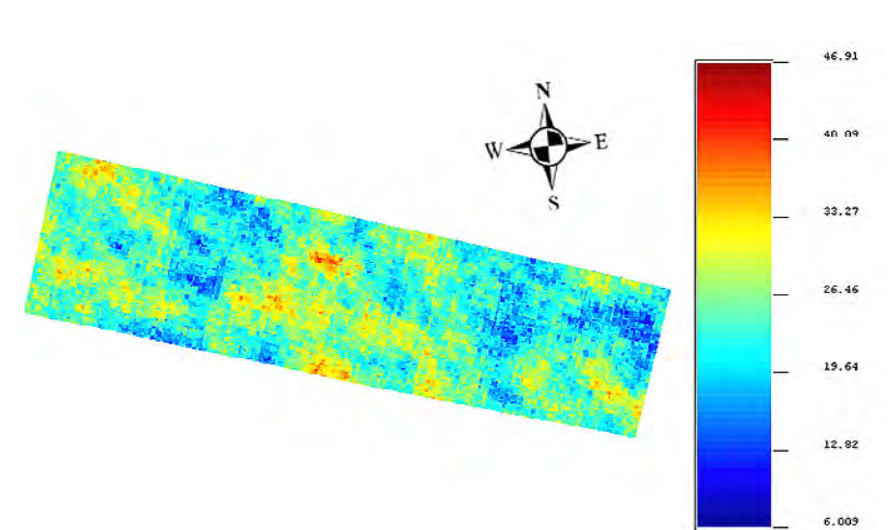
Figure 9a. R Realization Example